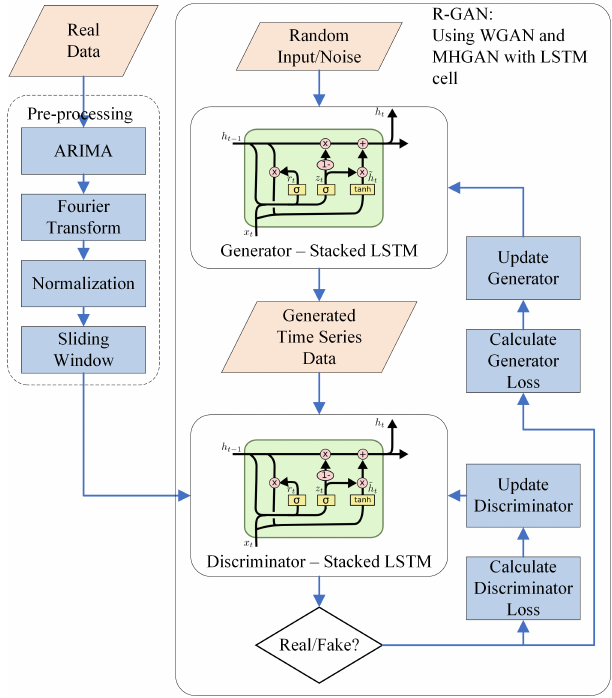
Figure 3. Recurrent Generative Adversarial Networks (GAN) for Energy